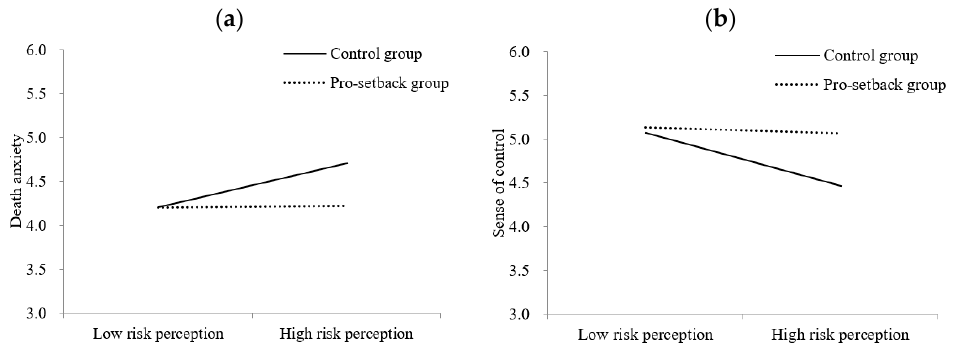
Figure 2. Confucian coping moderated the effect of risk perception on death anxiety ( a ) and sense of control ( b ) in Study 4.